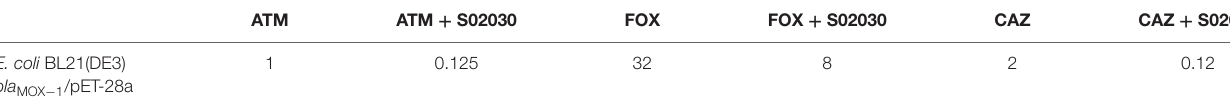
TABLE 2 | MIC data of antibiotics* in presence and absence of S02030 (4 µ g/ml). ATM ATM + S02030